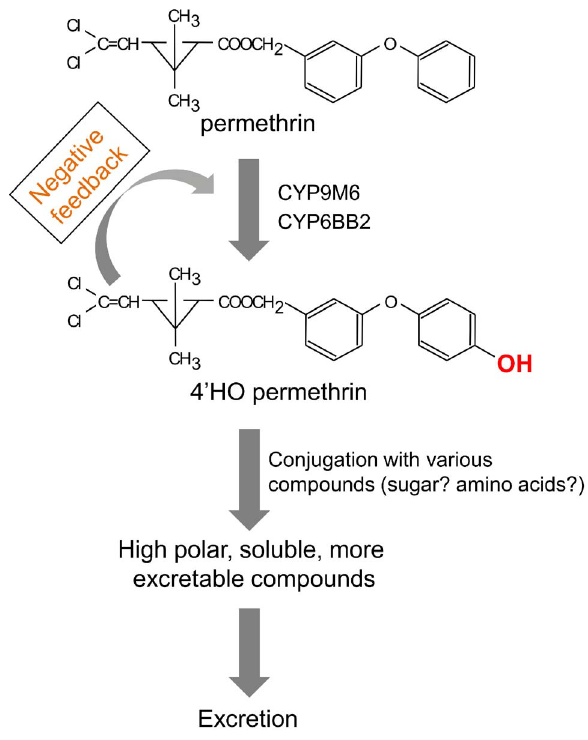
Figure 9. Proposed model showing the metabolic pathway of